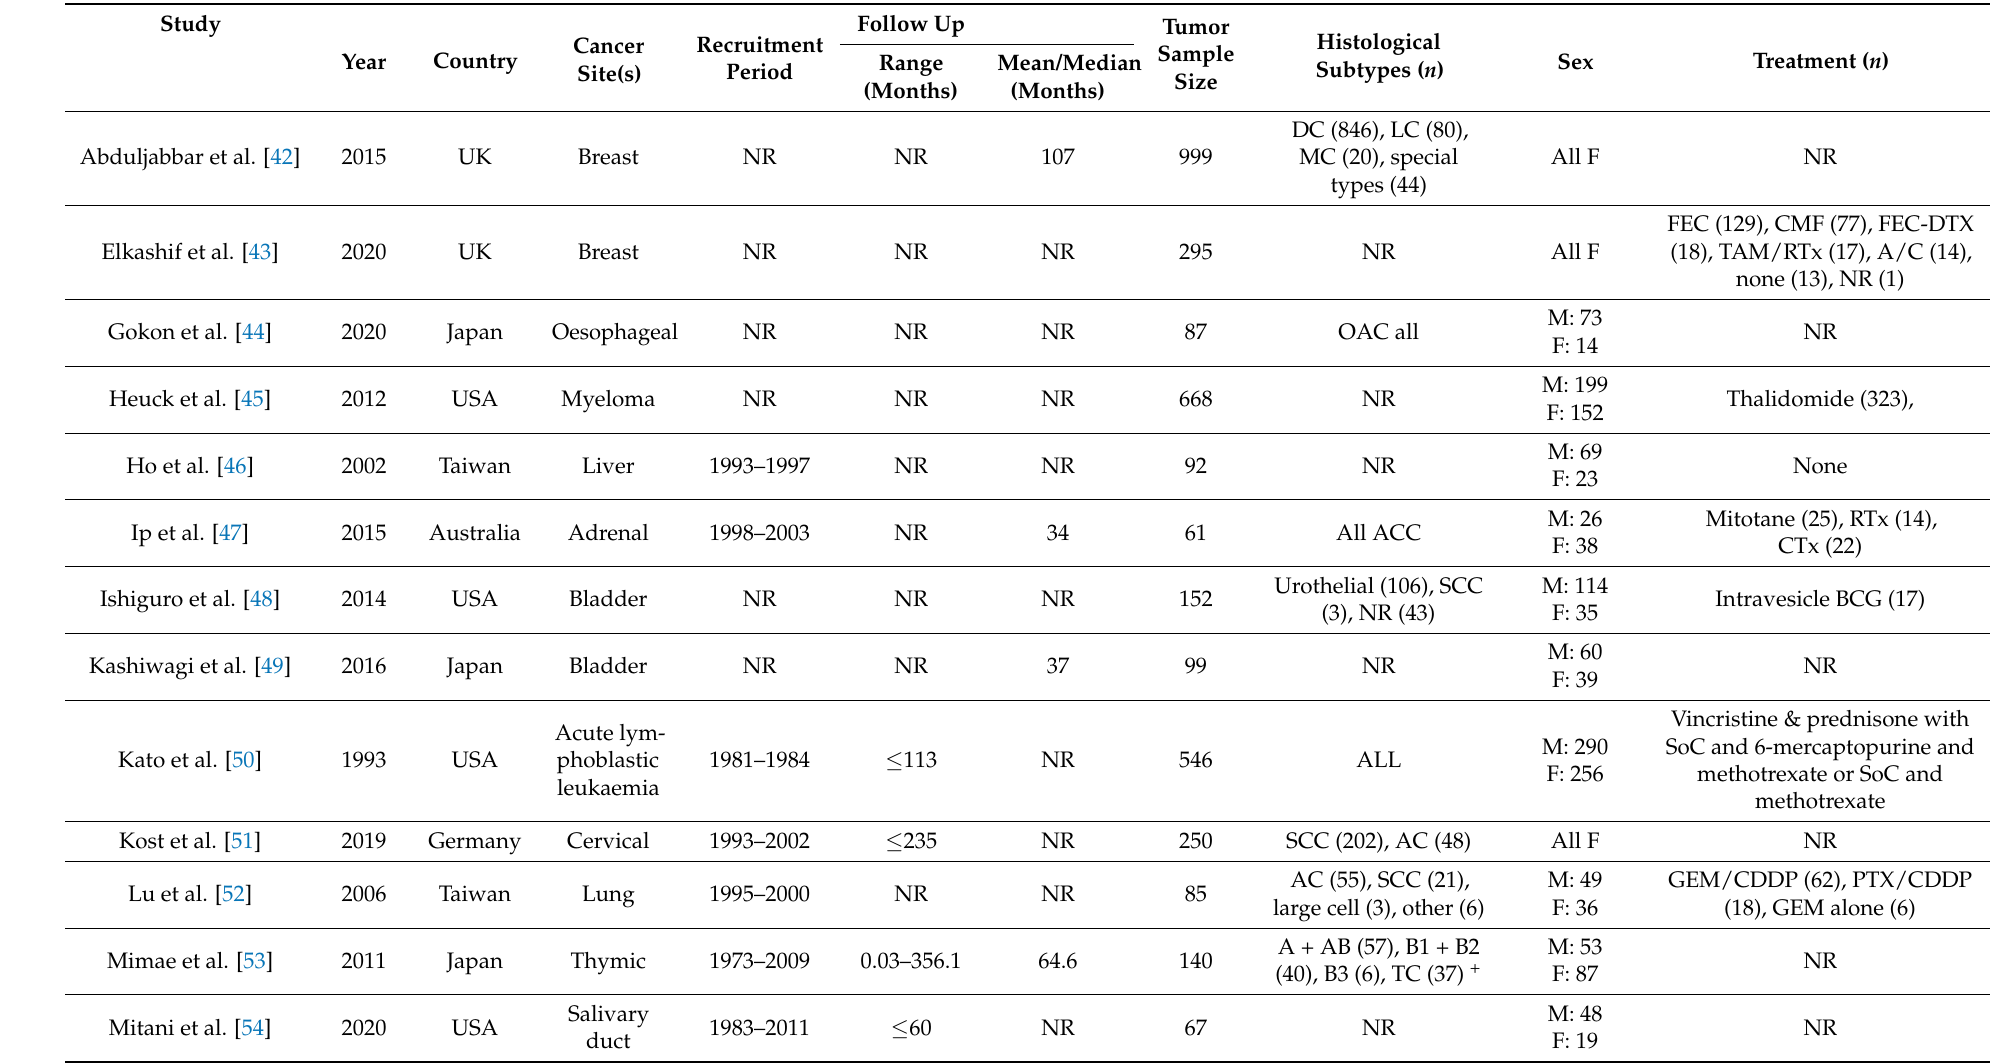
Table 1. Study characteristics of articles included in the